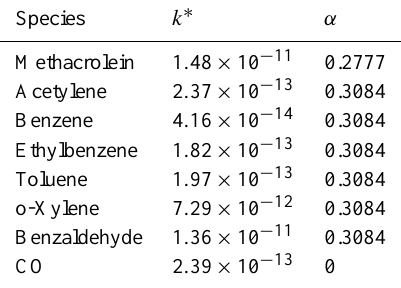
Table 1. Species involved in the calculation of peroxy nitrate and ozone production, their weighted reaction constant with OH ( k ∗ ex- pressed in cm 3 s − 1 ; see the text on how it is calculated), and the (cid:54) PN branching ratio ( α) .